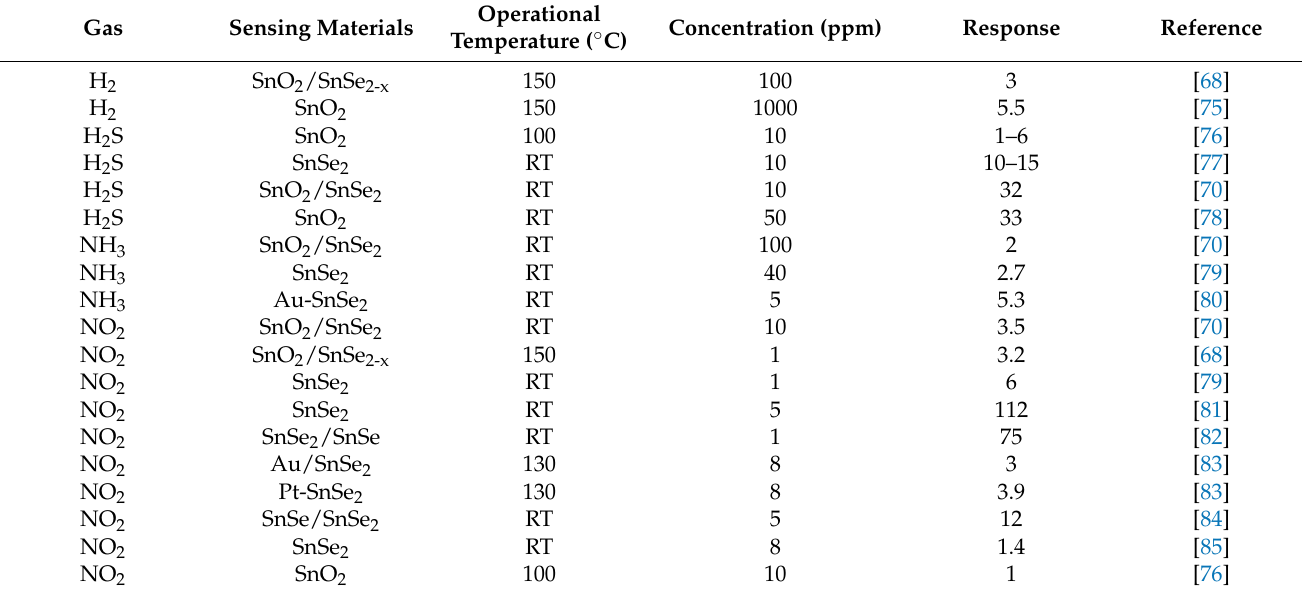
Table 4. Sensing of H 2 , H 2 S, NH 3 , and NO 2 for SnSe 2 - and SnO 2 -based systems. The response obtained at the respective operational temperature and gas concentration is reported. RT means room temperature.